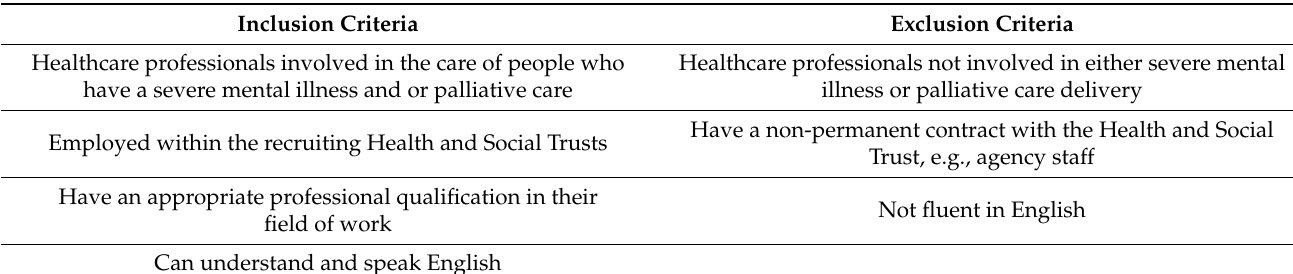
Table 2. Inclusion and exclusion criteria for Phase 4